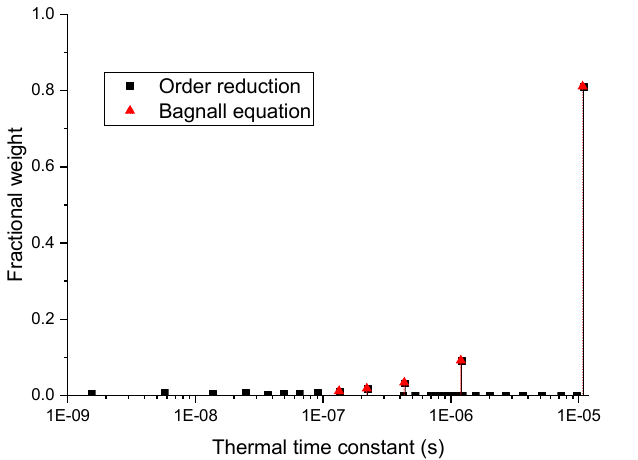
Figure 3. Normalized temperature response versus time (inset log (Temperature) vs log (time)).